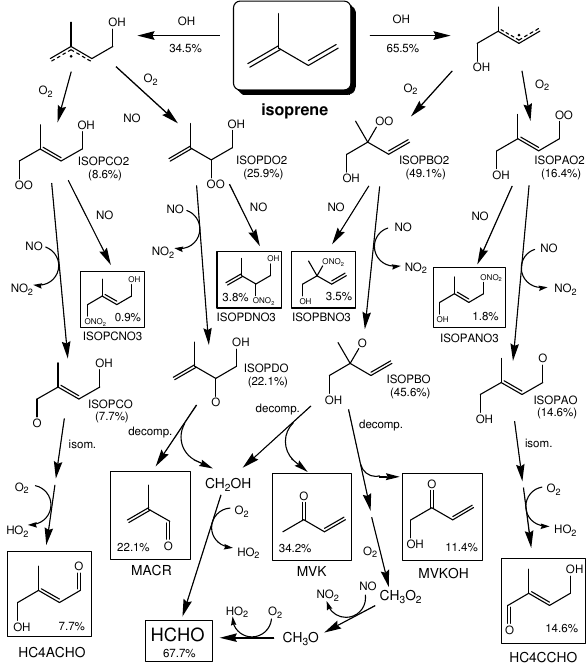
Fig. 1. MCM v3.1 representation of the OH initiated degradation Figure 1. MCM v3.1 representation of the OH initiated degradation of isoprene to first 3 of isoprene to first generation products, in the presence of sufficient generation products, in the presence of sufficient NO x such that NO provides the dominant 4 NO x such that NO provides the dominant reaction partner for the reaction partner for the peroxy radicals. Species names correspond to those appearing in 5 peroxy radicals. Species names correspond to those appearing in MCM v3.1. Closed-shell products are displayed in boxes, along with their molar yields. 6 MCM v3.1. Closed-shell products are displayed in boxes, along with their molar